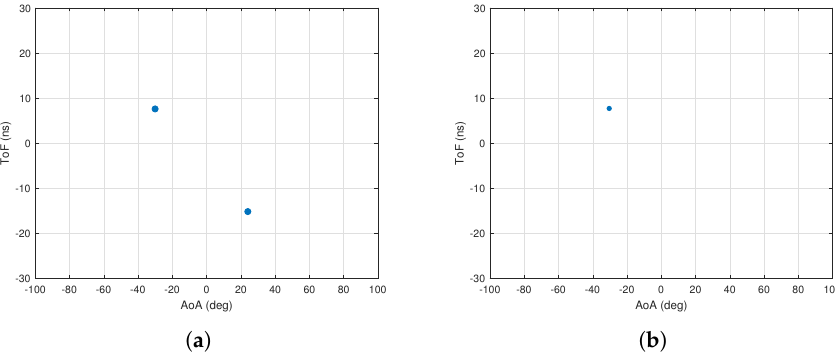
Figure 8. Performance using CSI from experiment. ( a ) performance of MMP with real CSI data.